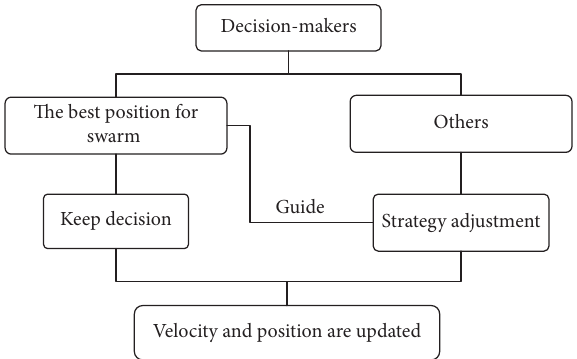
Figure 3: Human cognitive psychology optimal